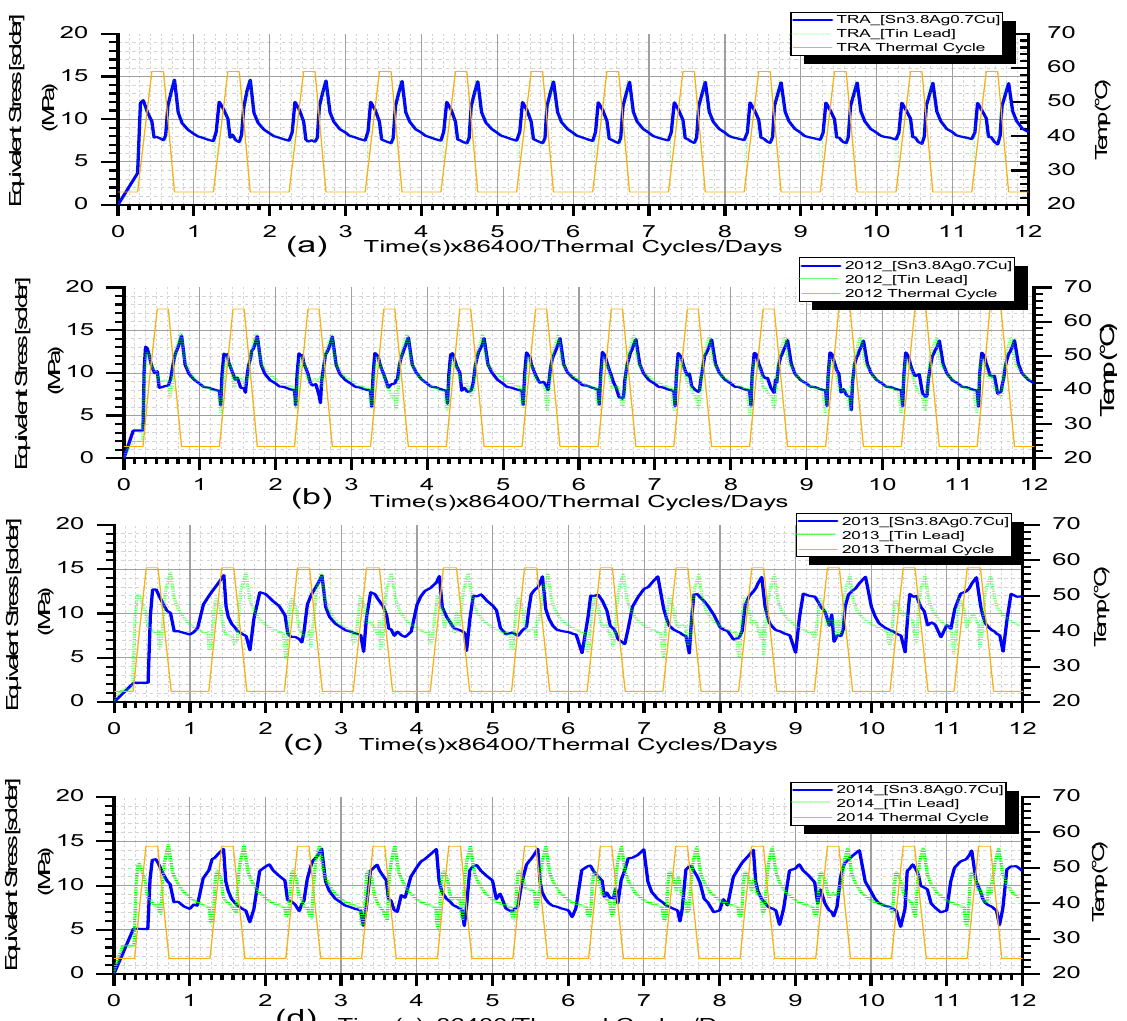
Figure 6. Equivalent von-Mises stress response of SnPb solder and Pb-free (Sn 3.8 Ag 0.7 Cu) solder for: ( a ) TRA, ( b ) 2012, ( c ) 2013 and ( d ) 2014 thermal cycles.